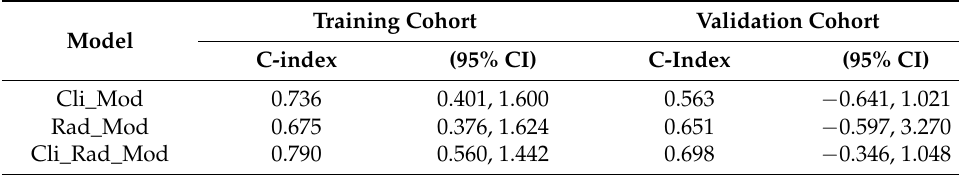
Table 4. The C-index of each model in the training and validation